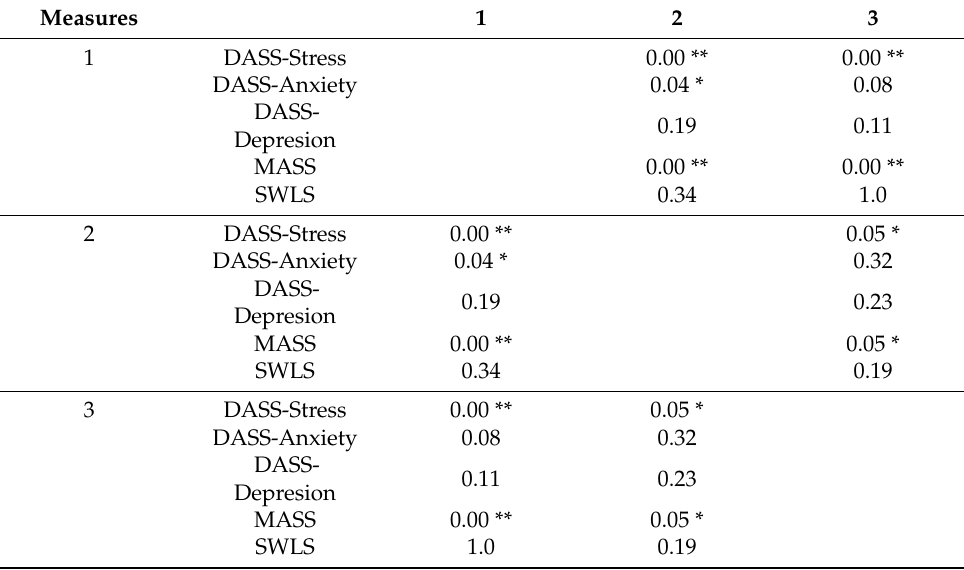
Table 5. Post hoc test ( p ): significance of the differences between measures based on the estimated marginal